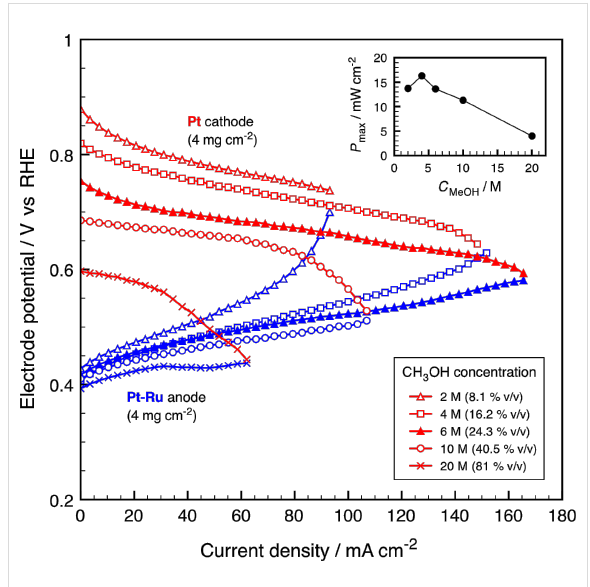
Figure 1: Current–potential characteristics of an air-breathing passive µDMFC. Pt–Ru anode (4 mg·cm − 2 ), and Pt cathode (4 mg·cm − 2 ). Inset shows the maximum power density as a function of the CH 3 OH